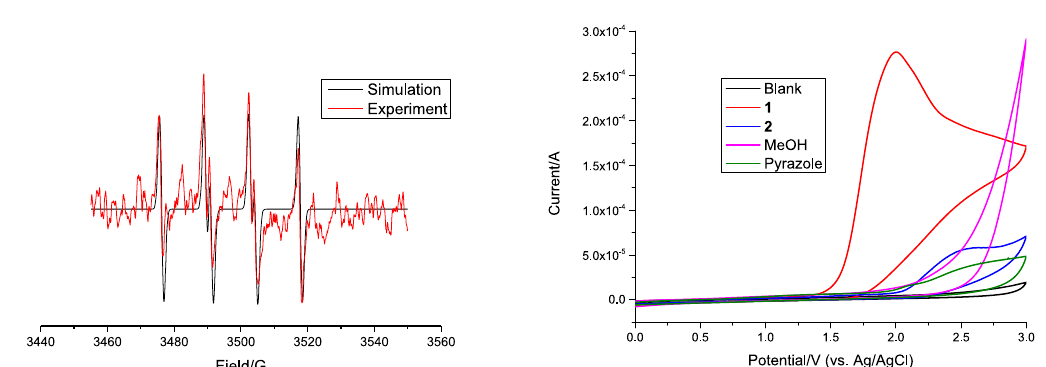
Fig. 4 | Theapplicationofthe method and the mechanistic experiments.a Intramolecularcyclization reaction. b Derivatizations ofproduct. c Synthesis of a series of trans- β -lactams. d Radical capture experiments. e EPR spectrum. f CV